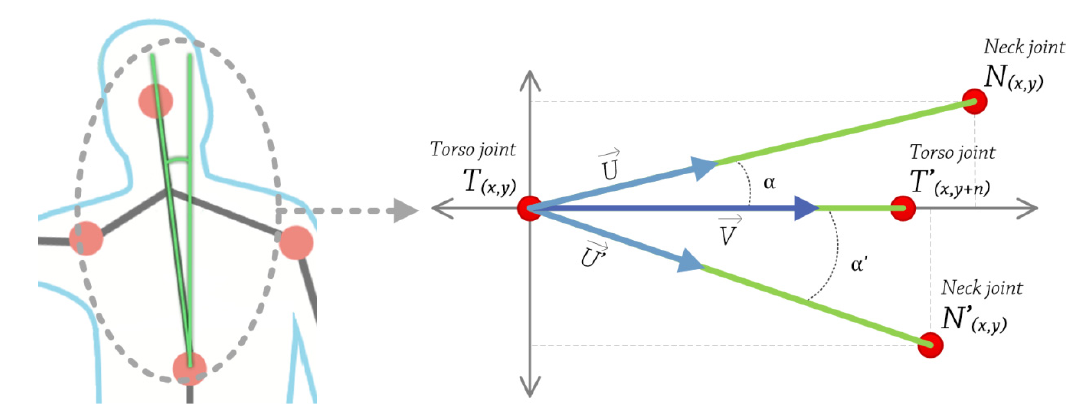
Figure 7. Trunk’s angle